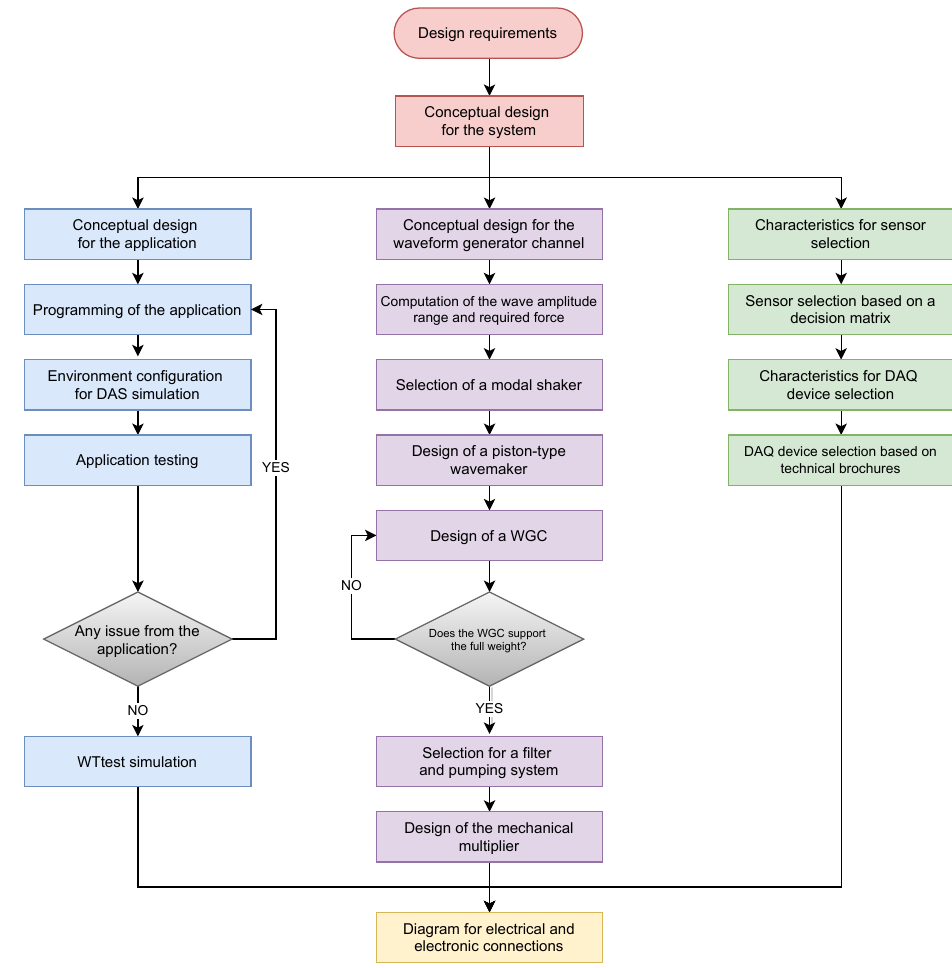
Figure 3. Flowchart of the design process for the work. Table 1. Design requirements for the